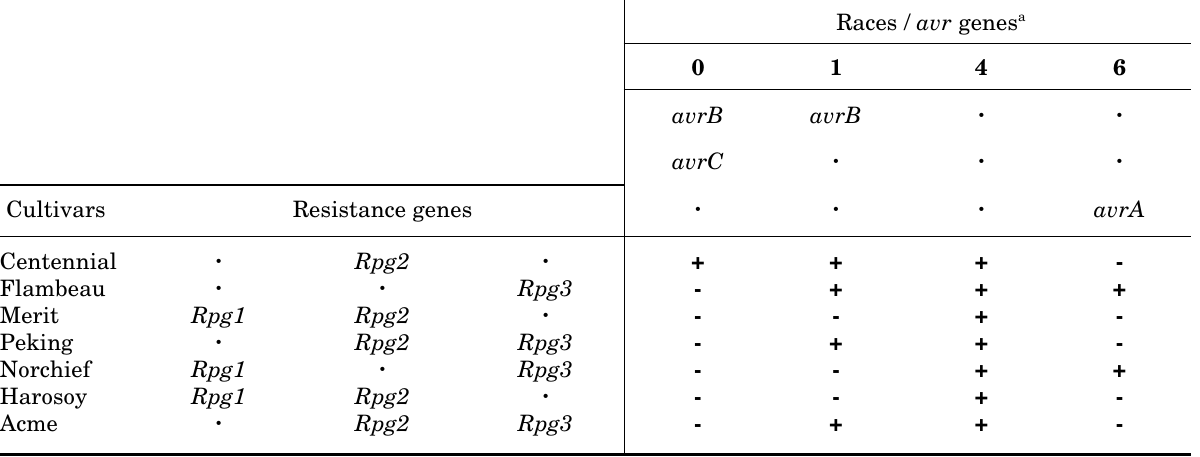
Table 6. Partly validated model to explain observed interactions between races of Pseudomonas syringae pv. gly- cinea and cultivars of the host,